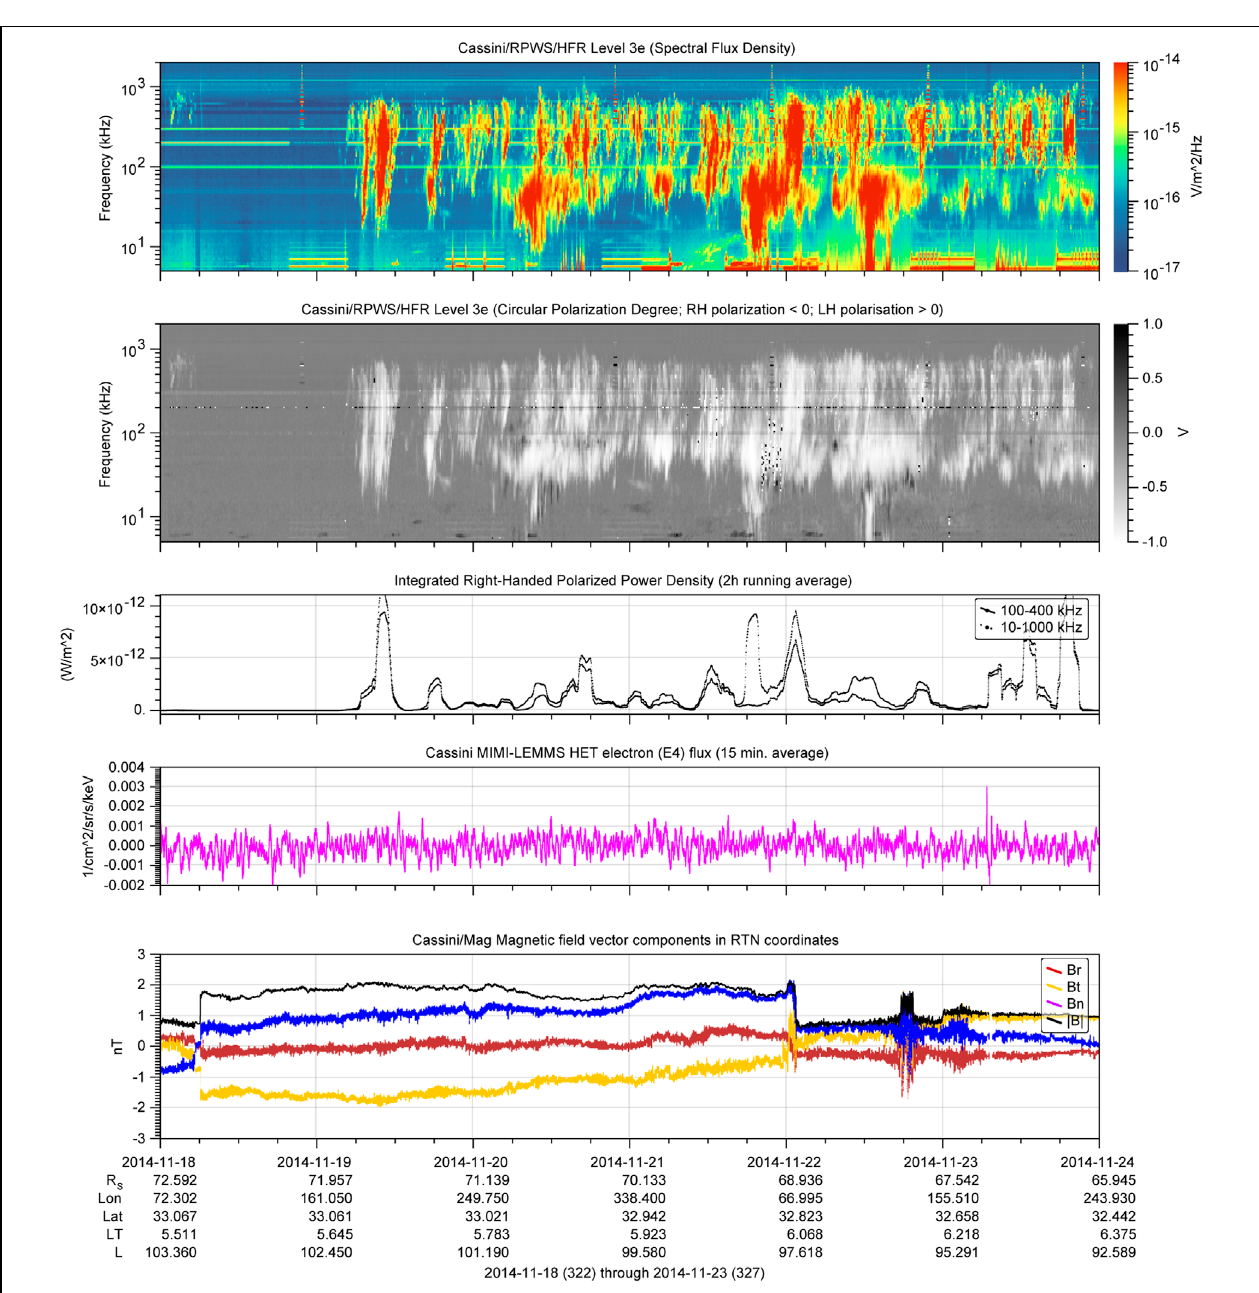
FIGURE 8 | Zoomed-in version of Figure 4 , from Nov. 18th 00:00 SCET to Nov. 24th 10:00 SCET. The panel description is the same as for Figure 4 . Times are given in the format YYYY-MM-DD, and hh:mm.